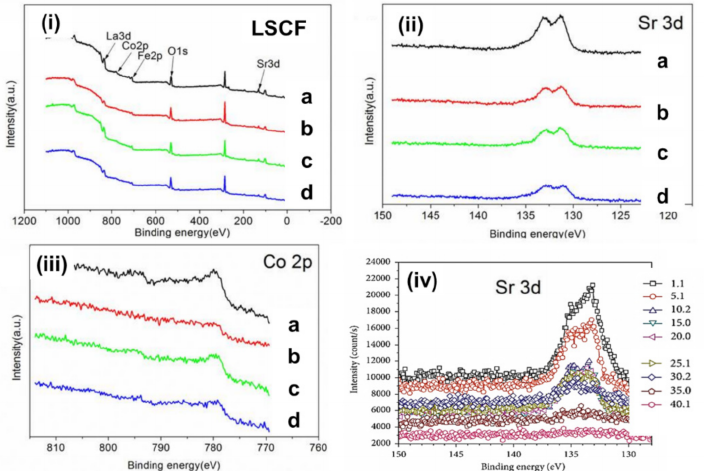
Figure 4. ( i ) XPS spectra of LSCF, showing La 3d, Sr 3d, Co 2p, and Fe 2p peaks ( ii ) magnified image of Sr 3d peak ( iii ) magnified image Co 2p peak for (a) as-prepared sample, (b) under open circuit at 750 ◦ C in the air for 120 h, (c) polarized sample under 100 mA cm − 2 at 750 ◦ C for 120 h, and (d) polarized sample under 200 mA cm − 2 at 750 ◦ C for 120 h. (iv) Sr 3d peaks obtained from XPS depth profile measurements at different depths in micrometers ((( i – iii ) reprinted with permission from Reference [35], copyright Elsevier, 2018) and ( iv ) reprinted with permission from Reference [31], copyright Hindawi, 2018).